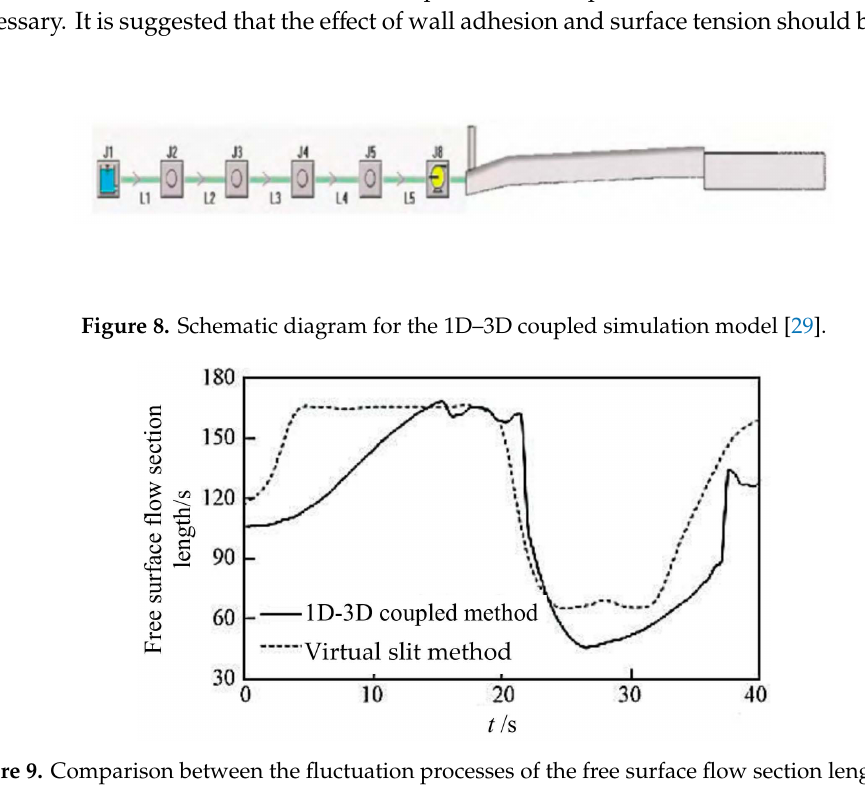
Figure 9. Comparison between the fluctuation processes of the free surface flow section length of the 1D–3D coupled method and the virtual slit method [29].